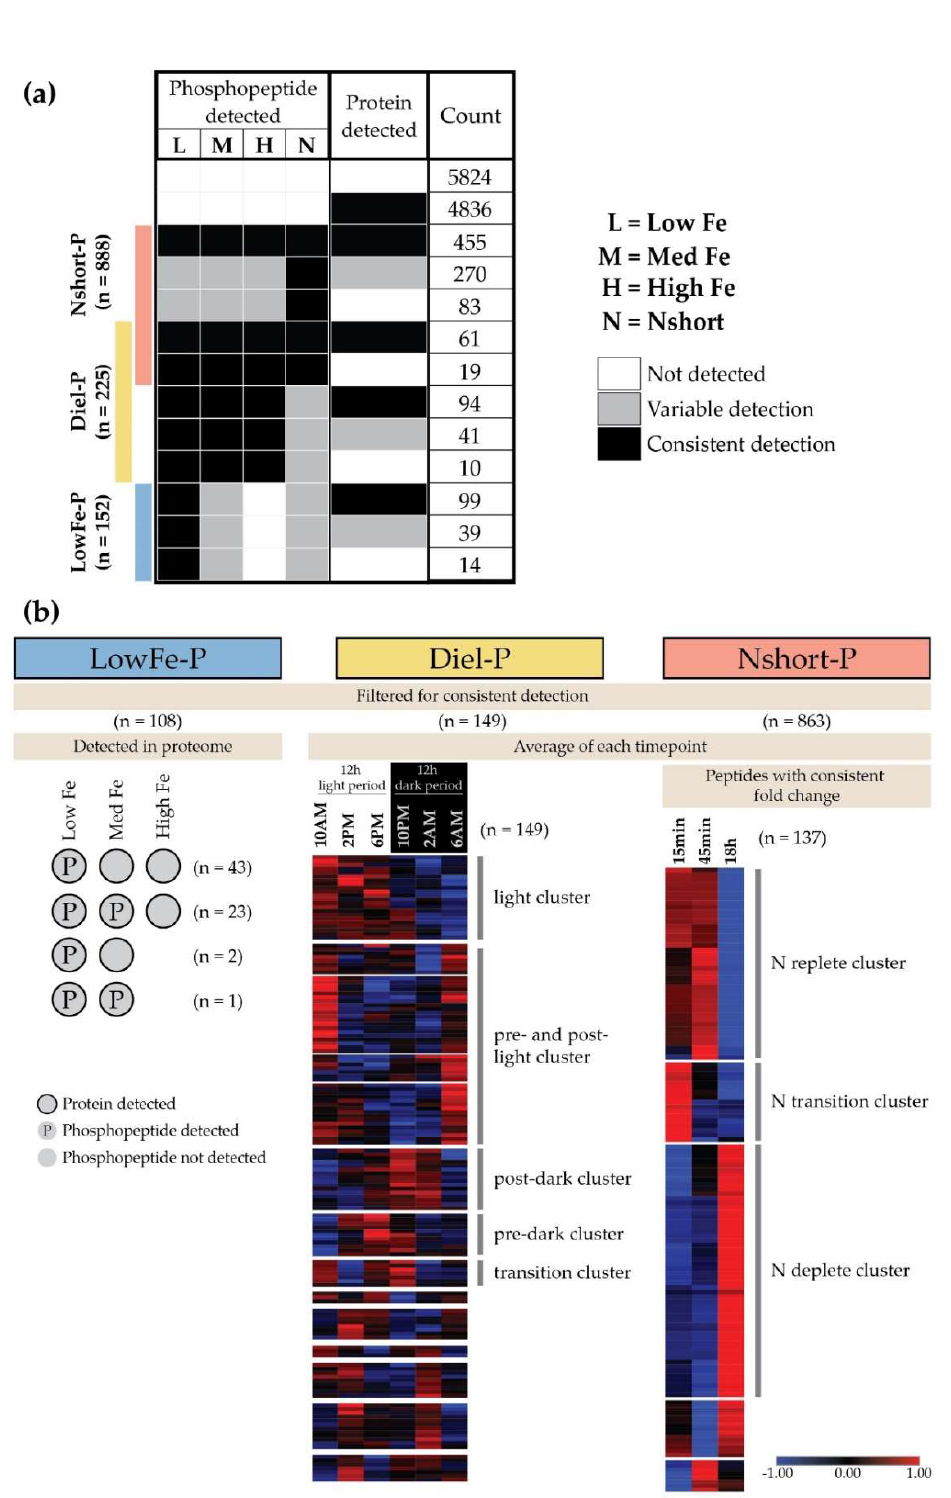
Figure 2. Division of phosphoproteome into conditional subsets. ( a ) Patterns of conditional phosphorylation compared to total protein expression as a response of P. tricornutum to low Fe (LowFe-P), diel light cycling (Diel-P), and N availability (Nshort-P) consisted of 10%, 15% and 59% of the phosphoproteome respectively. ( b ) Breakdown of LowFe-P subset by pattern. Diel-P Fe treatments were averaged by timepoint to highlight the phosphorylation changes due to the diel cycle. Similarly, to illustrate the response to cellular N status, Nshort-P nitrogen treatments were averaged and log2FC was calculated between timepoints. Normalized phosphopeptide abundances were hierarchically clustered.